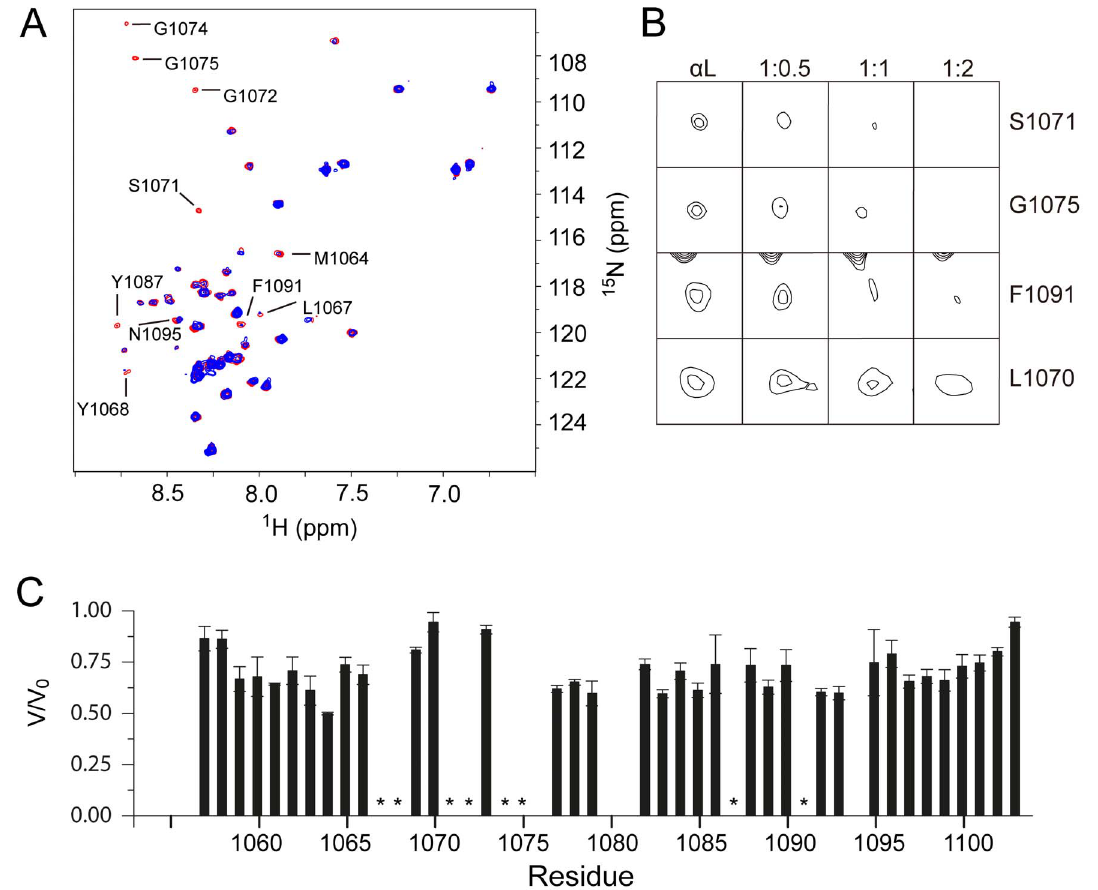
Figure 4. Interaction between a L and b 2 TM domains. (A) Result of the titration of 15 N-labeled a L TM by unlabeled b 2 TM at a L/ b 2 1:2 molar ratio, monitored by [ 1 H- 15 N] -HSQC. The spectra in red represent the a L TM alone, while the one in blue was obtained after addition of b 2 TM. Residues most affected are labeled; (B) Selected regions in the [ 1 H- 15 N] –HSQC spectrum at increasing a L/ b 2 molar ratios indicated showing intensity reduction and disappearance of selected peaks Ser-1071, Gly-1075, Phe-1091. Leu-1070 is shown for comparison; (C) Peak intensities expressed as ratio between peak volume after (V) and before (V 0 ) addition of unlabeled b 2 TM to labeled a L TM. Residues that experience extreme line broadening are indicated by *. Missing/overlapping resonances, e.g., R1094, are not